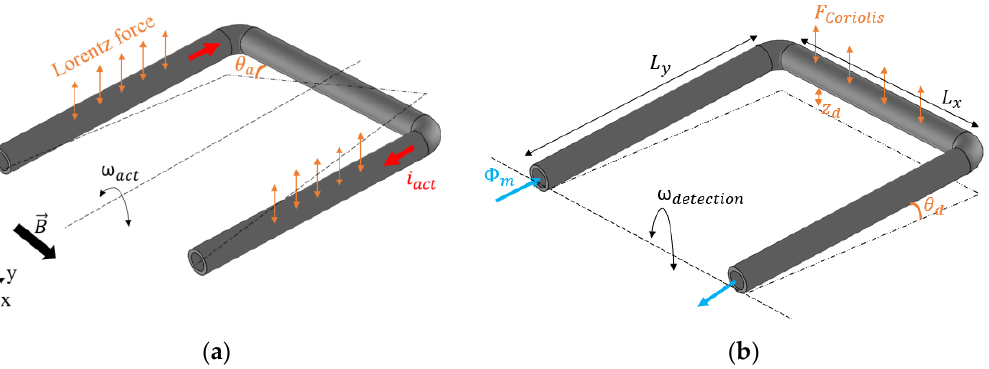
Figure 1. A U-shaped free-suspended tube that is fixed at both ends. ( a ) Twist mode vibration due to Lorentz force, and ( b ) swing mode vibration due to Coriolis force. 𝜔 𝑎𝑐𝑡 and 𝜔 𝑑𝑒𝑡𝑒𝑐𝑡𝑖𝑜𝑛 are the actuation and detection mode of angular velocity, respectively.